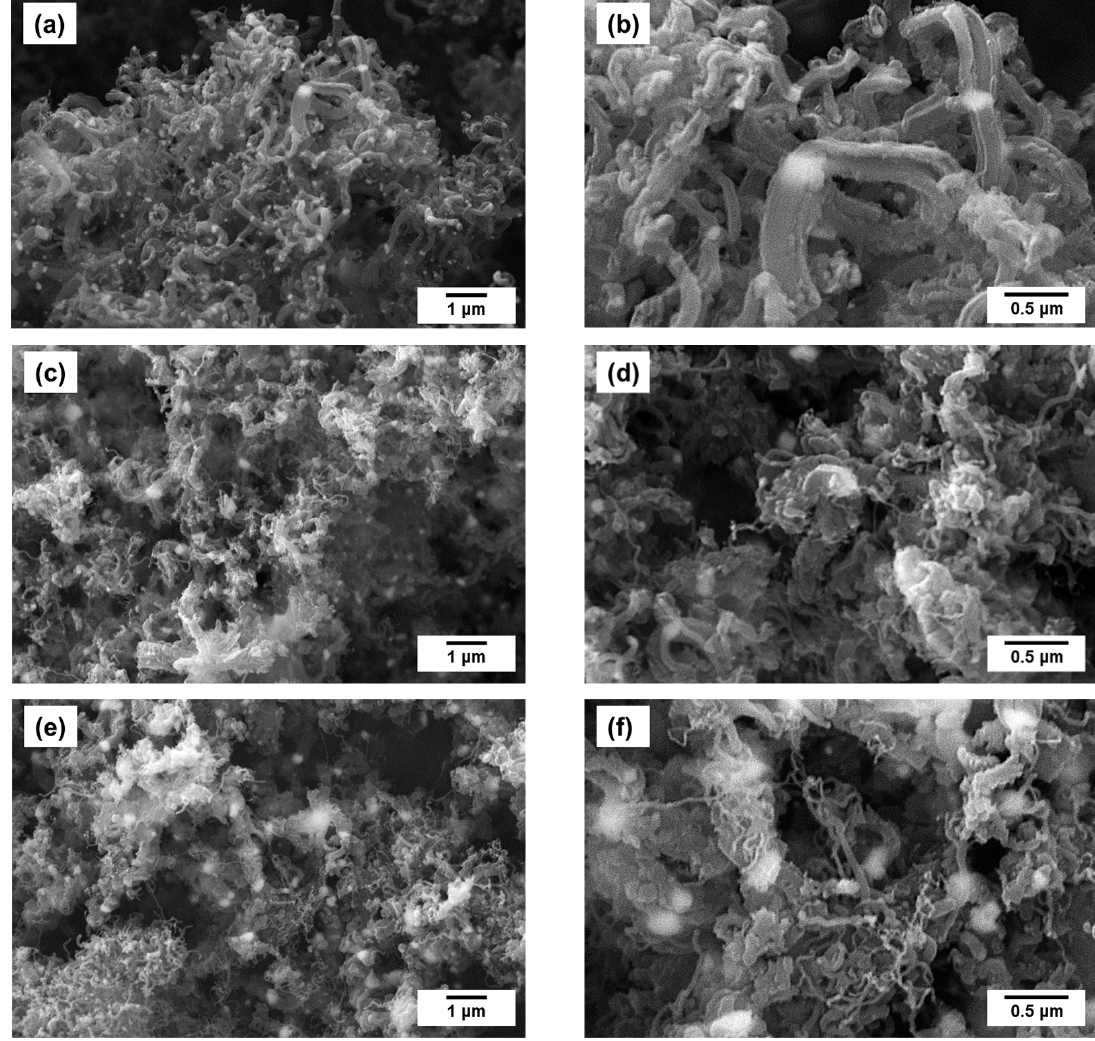
Figure 7. SEM images (back-scattered electron beam mode) of Pt 1 − x Ni x /CNF composites obtained via ethylene decomposition at 600 °C: ( a , b ) x = 0.60, t = 5 min, Y CNF = 4.5 g/g cat ; ( c , d ) x = 0.80, t = 4 min, Y CNF = 4.3 g/g cat ; ( e , f ) x = 0.90, t = 3 min, Y CNF = 4.3 g/g cat .